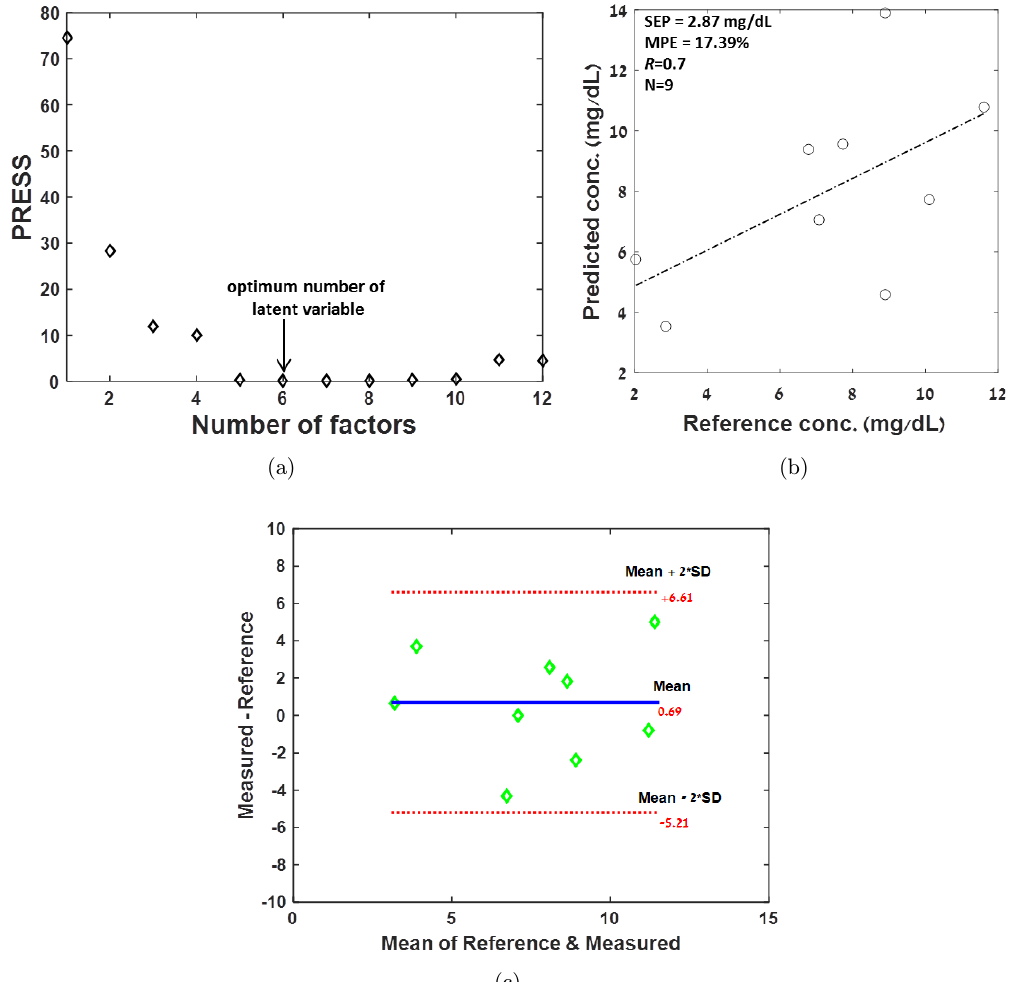
Fig. 4. (a) Plot of PRESS versus the number of PLS factors; six factors were determined to be optimal indicated by the arrow. (b) Predicted Cr concentration versus reference (actual) with R ¼ 0 : 7 and SEP = 2.87 mg/dL. (c) Bland – Altman plot comparing NIR- calculated and reference values for nine measurement points. Bland – Altman parameters indicate a mean di®erence of 0 : 69 (cid:5) 2 : 95 mg/dL with CI 95 % (outer lines) of þ 6.61 and (cid:2) 5.21 mg/dL,